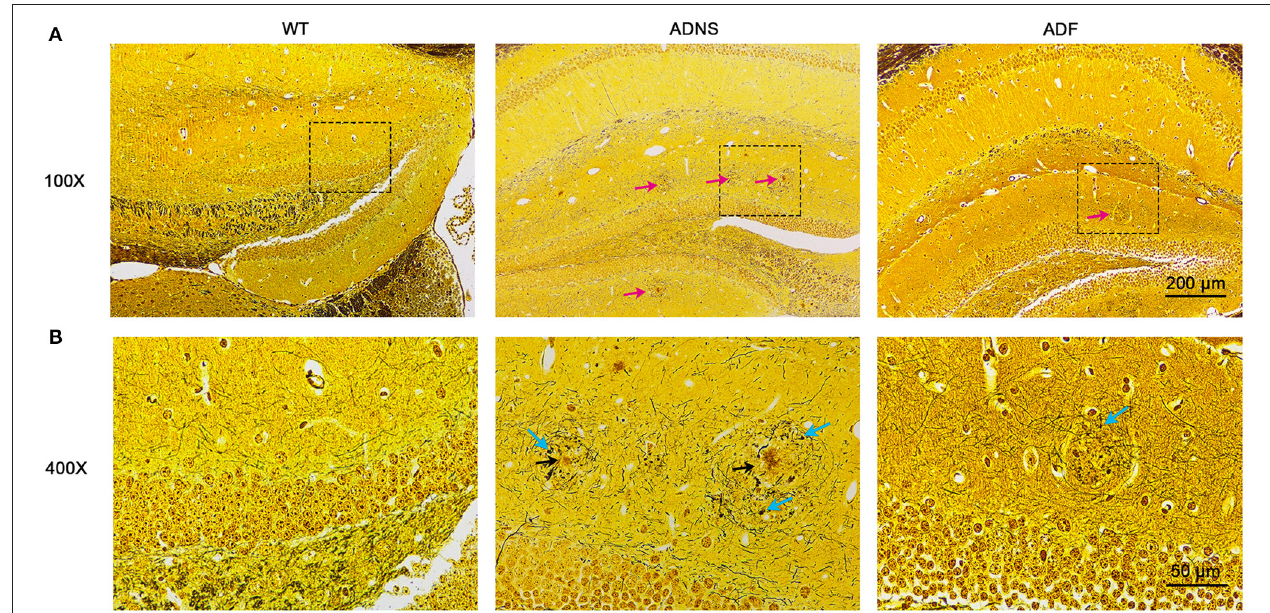
FIGURE 2 | Senile plaques and neurofibrillary tangles in the mouse hippocampus with Bielschowsky silver-plated nerve staining. (A) Representative images of hippocampal sections from WT and APP/PS1 mice treated with saline (ADNS) or fasudil (ADF). The neurofibrillary tangles (red arrow) were densely distributed in ADNS, but not in WT and only sparsely observed in ADF. (B) Magnification of the representative images (squared areas) of the hippocampal sections from WT, ADNS, and ADF mice. A large number of senile plaques (black arrow) and neurofibrillary tangles (blue arrow) were visible in ADNS, but not in WT and only occasionally in ADF. Scale = 200 µ m (A) or 50 µ m (B) .